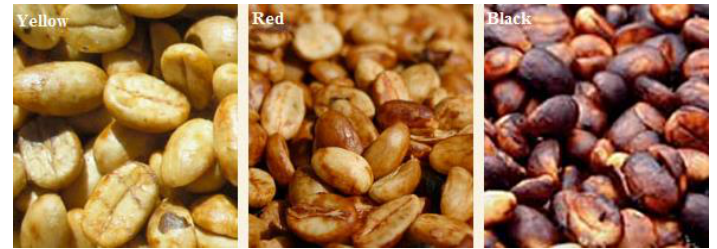
Figure 3. Appearance of honey processed coffee beans.